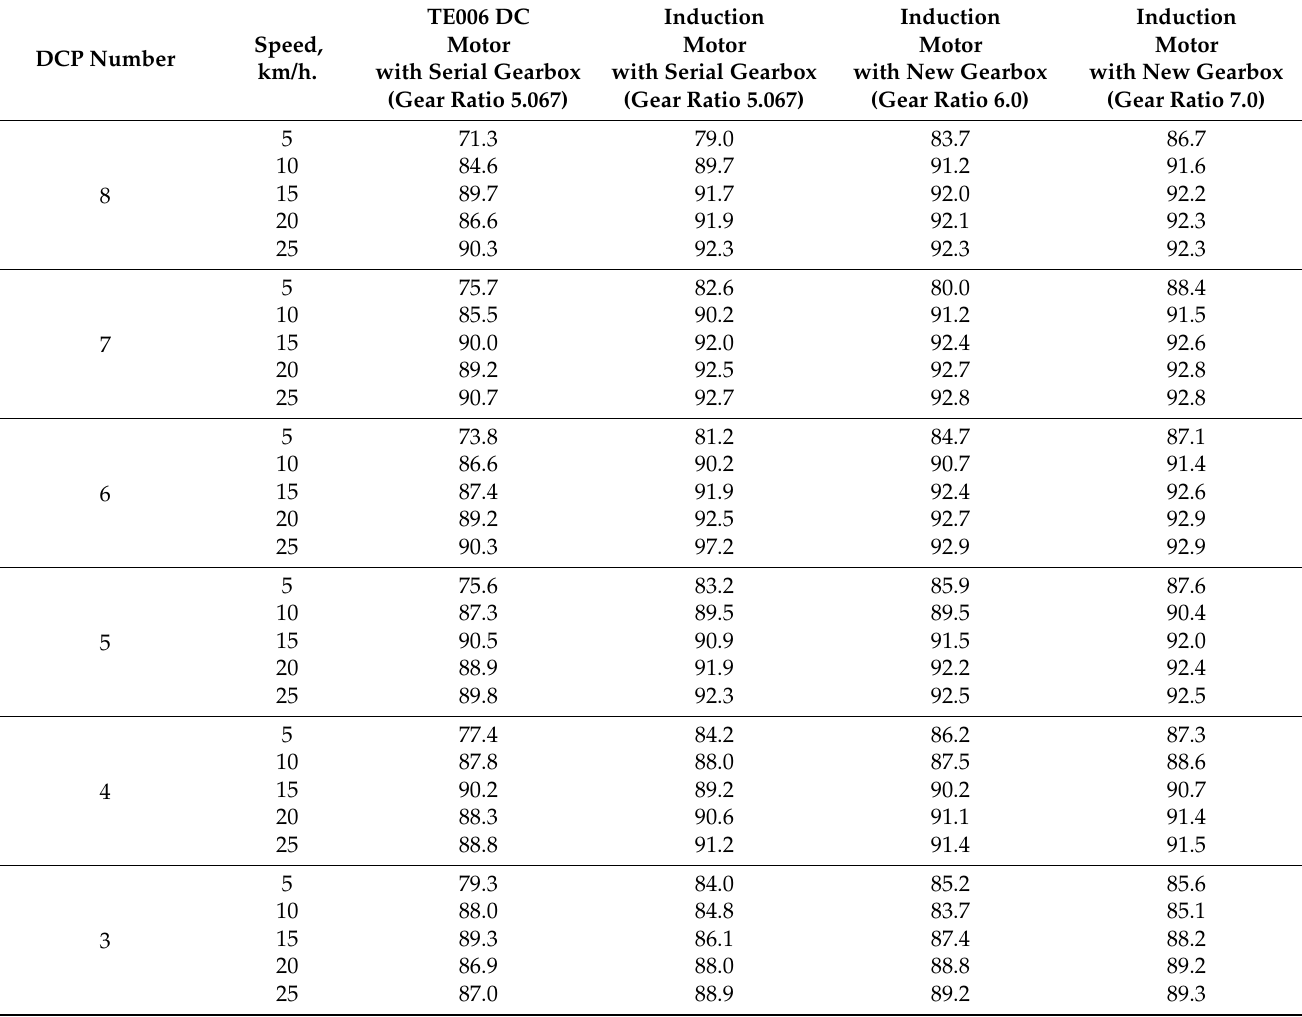
Table 6. The efficiency of the locomotive traction electric